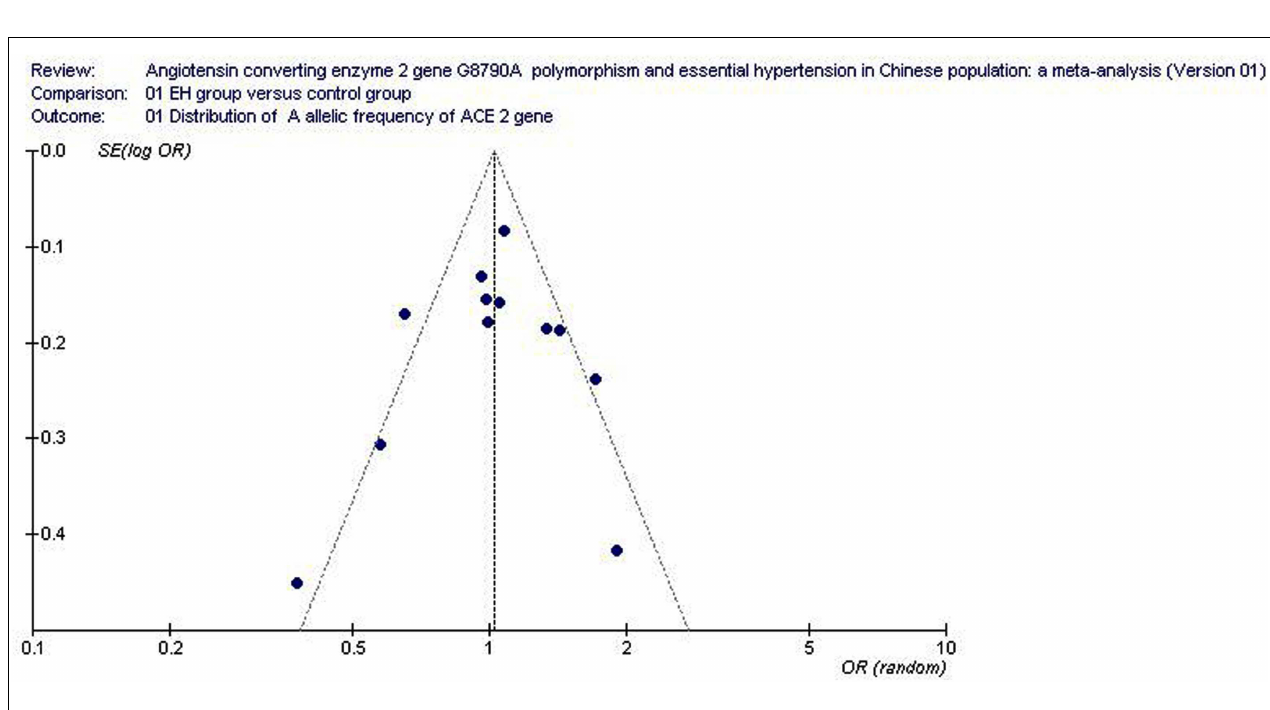
FIGURE 6 | Funnel plot for studies of the association of essential hypertension andACE2 G8790A gene polymorphism (distribution ofA